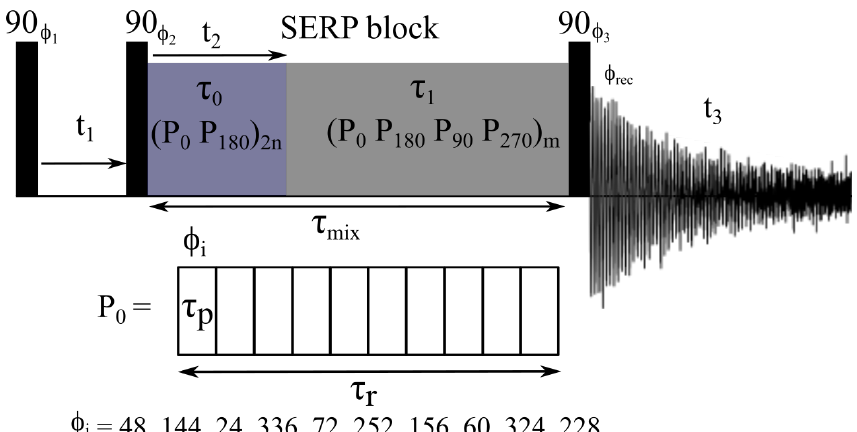
Figure 2. Pulse sequence for SElective Recoupling of Protons (SERP). For psuedo-2D implementation, a soft frequency selective pulse was applied for excitation. The phases used for the pulses were φ 1 = 0 2, φ 2 = 0 0 0 0 0 0 0 0 2 2 2 2 2 2 2 2, φ 3 = 0 0 2 2 1 1 3 3, and receiver phase φ rec = 0 2 2 0 1 3 3 1 2 0 0 2 3